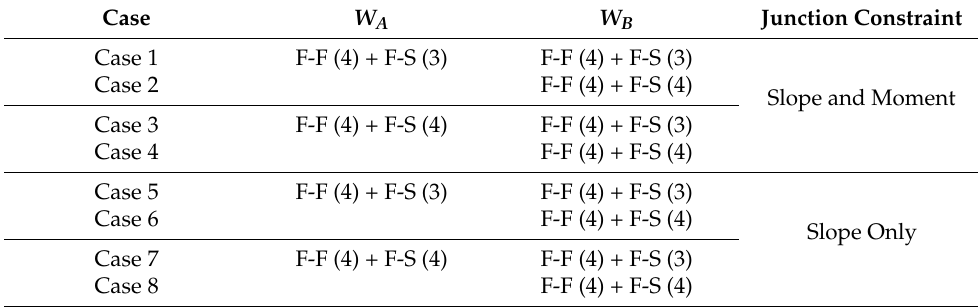
Table 7. The case of study for two components type.